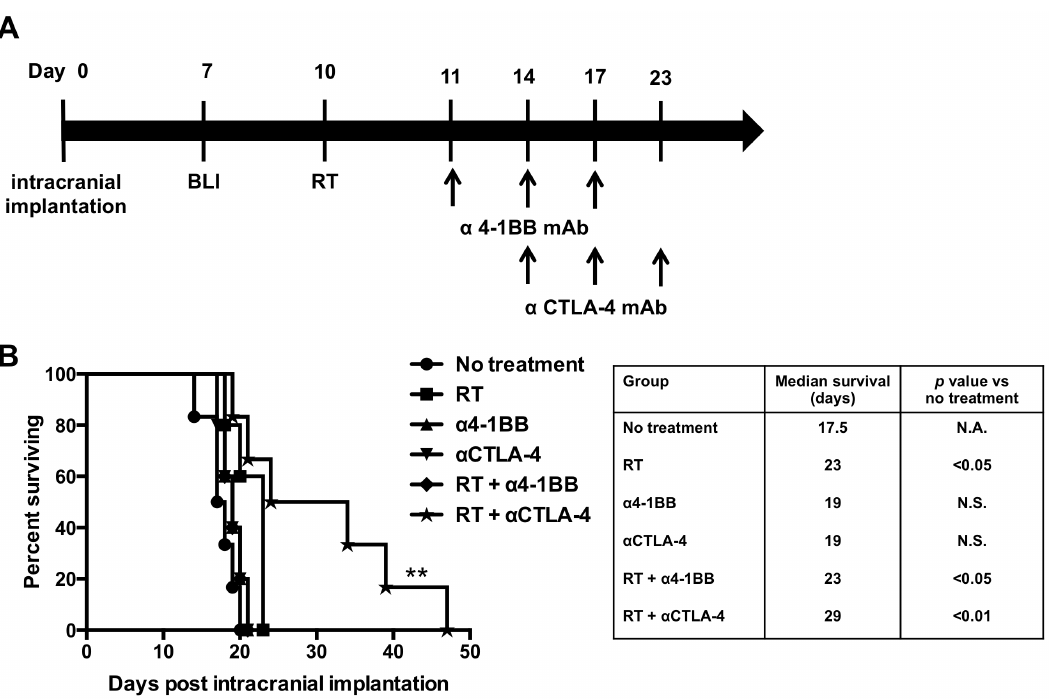
Figure 1. Focal radiation therapy combined with CTLA-4 blockade prolonged survival in established intracranial GL261 tumors. A) Schematic of the treatment protocol for combination therapy with RT and 4-1BB activation or CTLA-4 blockade. B) Kaplan Meier survival curves for single immunotherapy with anti-4-1BB antibodies and combination therapy with RT and 4-1BB activation or CTLA-4 blockade ( n =5–6 mice/group). Single immunotherapy with anti-4-1BB antibodies did not extend median survival ( p =0.16 vs. untreated mice). Combination treatment with RT and 4-1BB activation extended median survival times significantly ( p , 0.05 vs. untreated mice), however, this result was not significant when compared to treatment with focal RT alone ( p =0.99). CTLA-4 blockade alone did not extend median survival in treated animals, however, trended towards significance ( p =0.11 vs. controls). Combination therapy with RT and anti-CTLA-4 antibodies prolonged overall survival significantly compared to either treatment modality alone ( p =0.045 vs. RT; one-sided Log-Rank test). P values were calculated with the Log-Rank